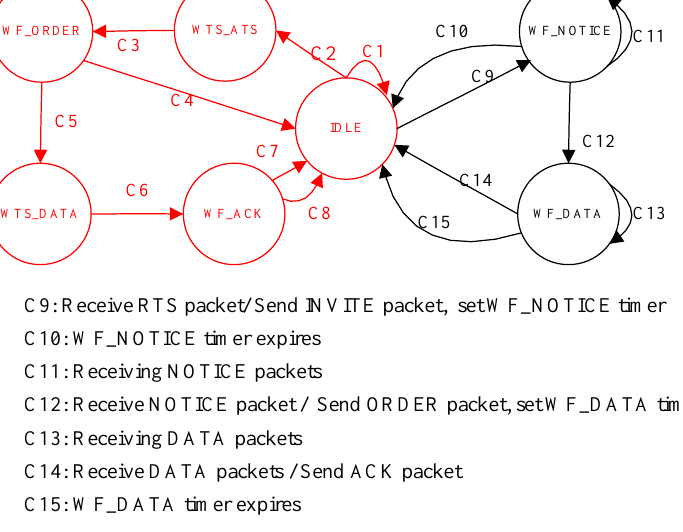
Figure 6. The whole state transition diagram of a level-1 node in the data-collection-oriented (DCO)-MAC protocol.